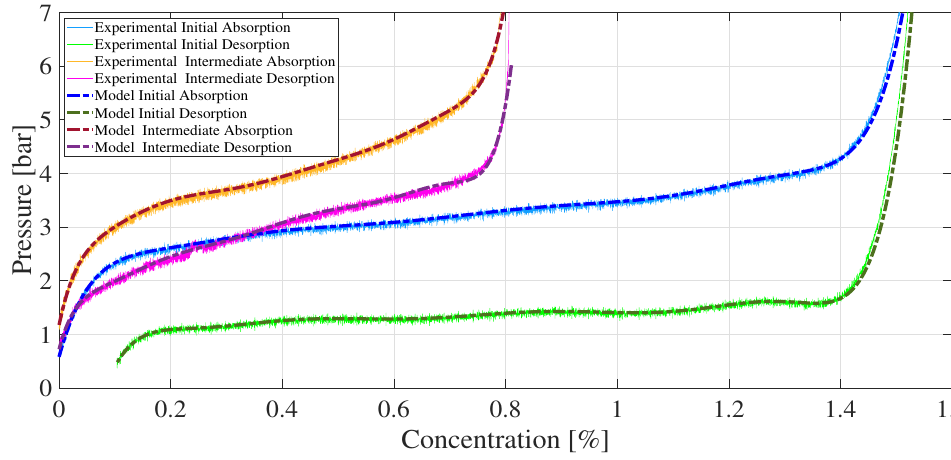
Figure 8. Experimental and model PCT at 21 ◦ C in healthy and degraded tank